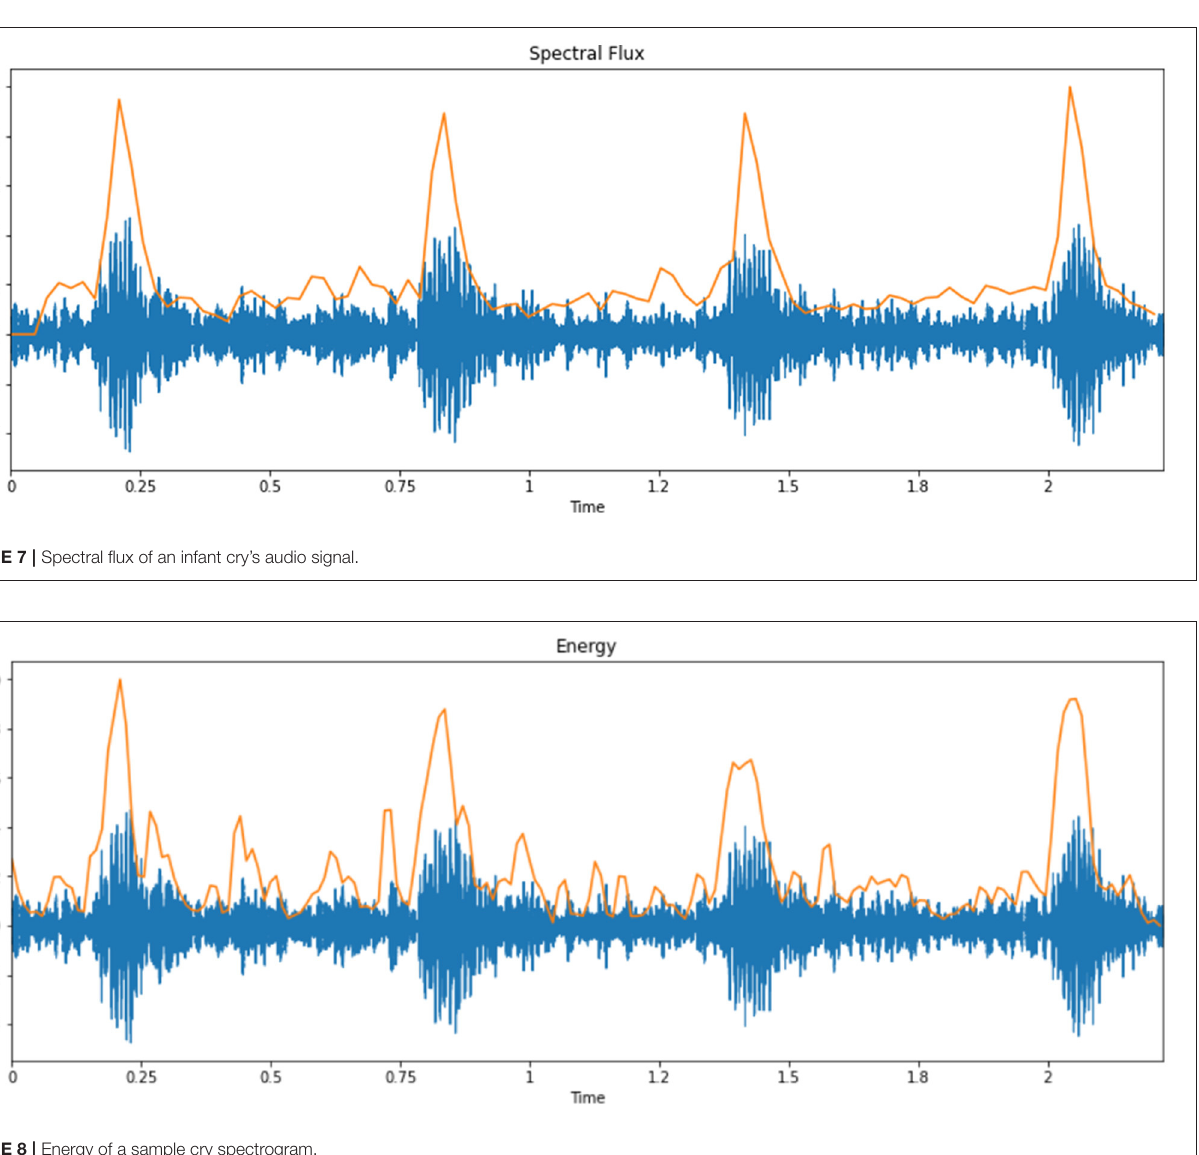
FIGURE 8 | Energy of a sample cry